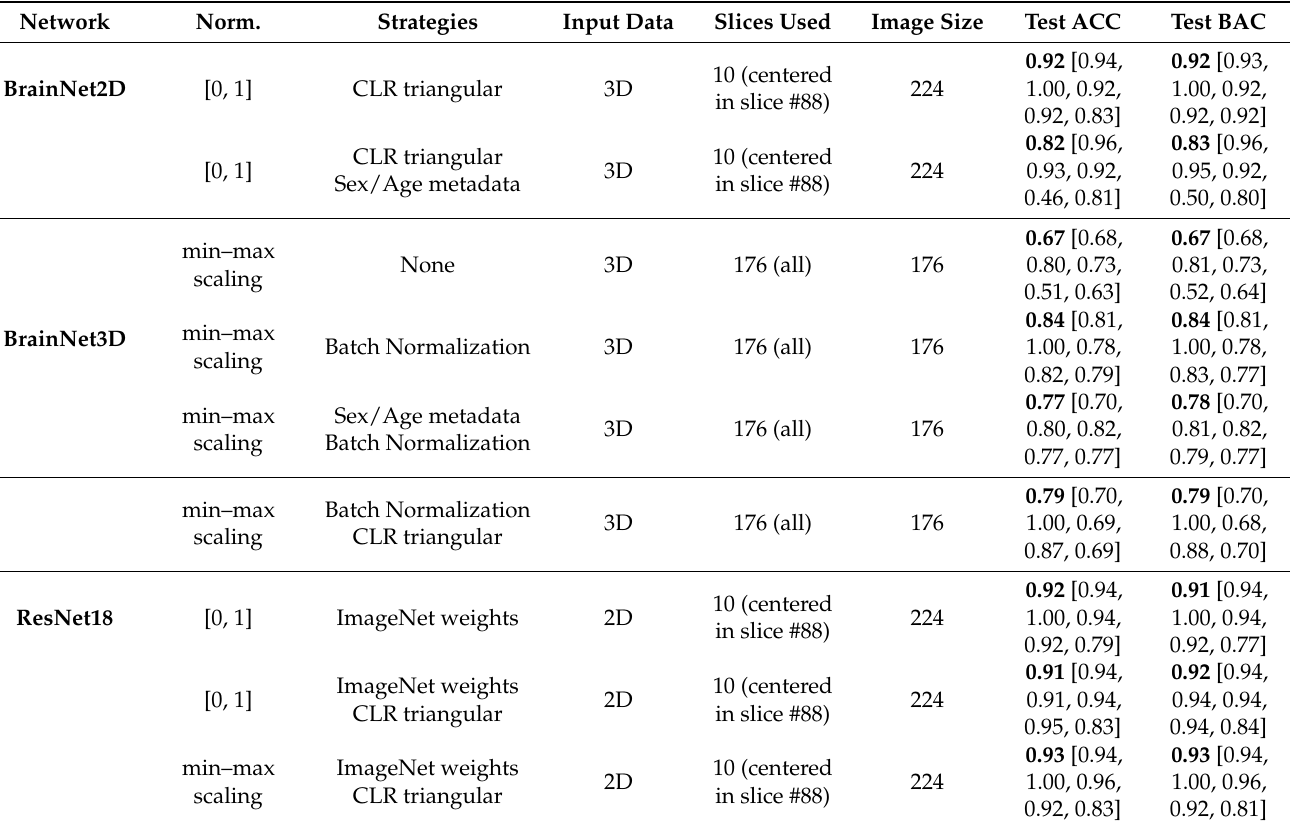
Table 3. Results for two classes classification, CDR = 0 (healthy), CDR = 0.5, 1, 2 (disease) over OASIS-2 dataset. Network